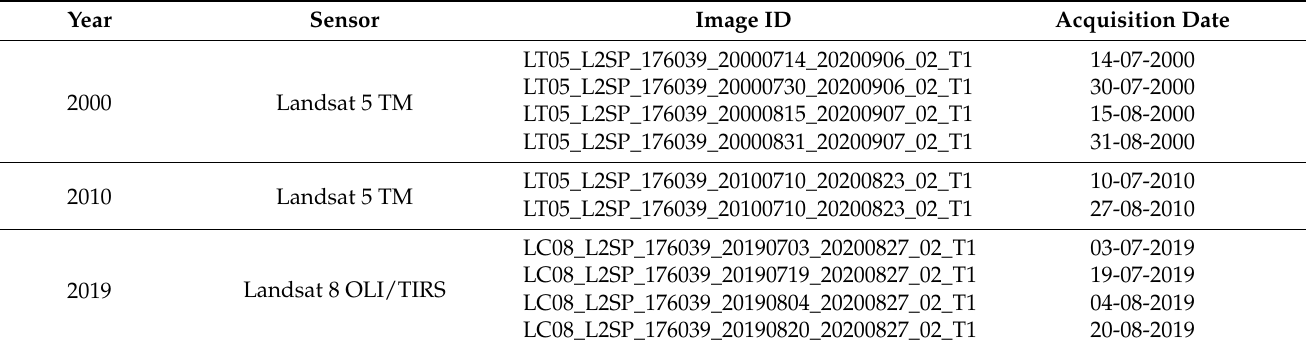
Table A1. List of Landsat images used in this study (Level 2). TM, Thematic Matter; OLI/TIRS, Operational Land Imager/Thermal Infrared Sensor.